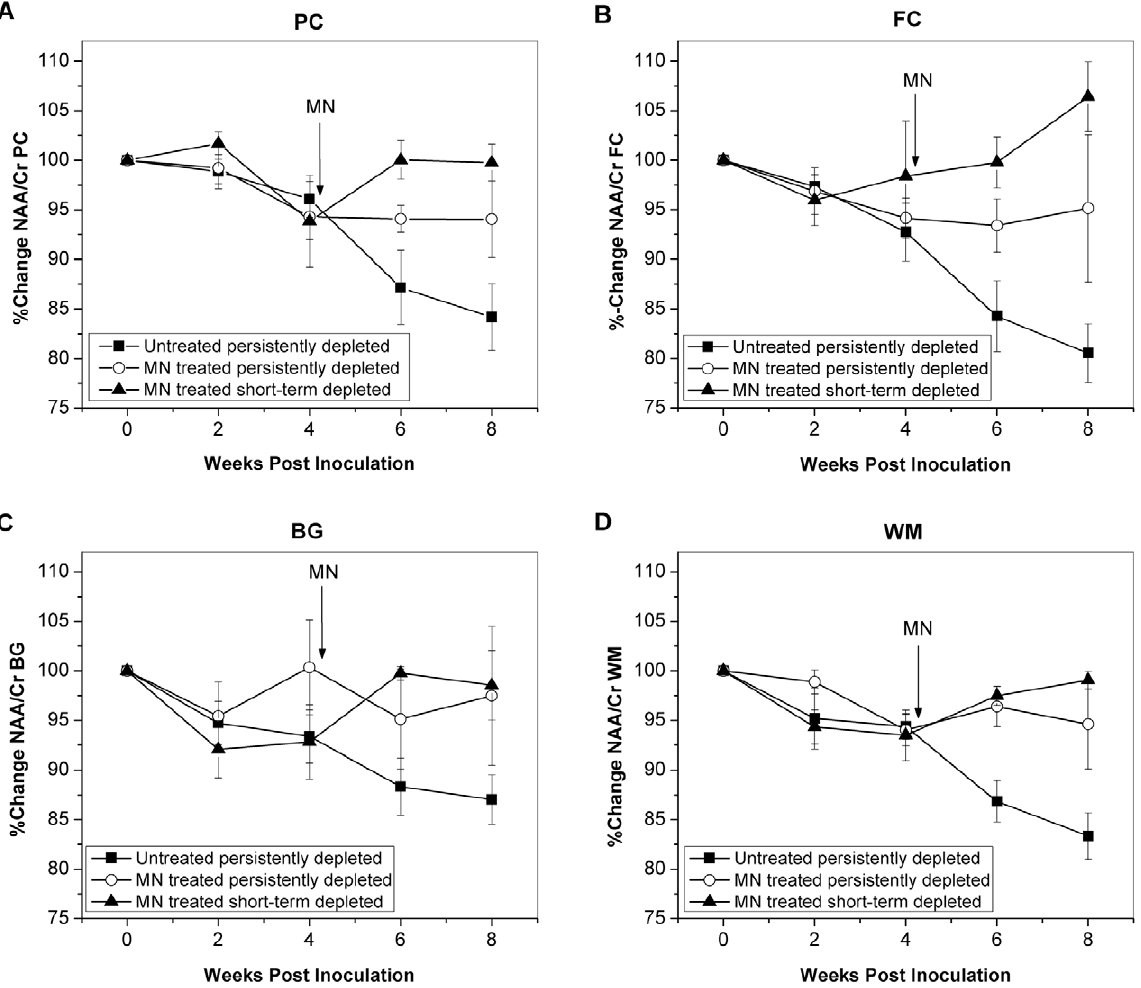
Figure 3. Recovery of neuronal marker NAA/Cr with minocycline treatment in SIV infection. NAA/Cr over the course of SIV infection in untreated animals (solid squares), minocycline (MN)-treated persistently CD8-depleted animals (open circles) and MN-treated short-term CD8- depleted animals (solid triangles). Mean NAA/Cr measured in the parietal cortex ( A ), frontal cortex ( B ), basal ganglia ( C ) and white matter semiovale ( D ) are plotted over time. Error bars represent standard error of the mean. The arrows represent the time point when minocycline (MN) treatment was initiated.